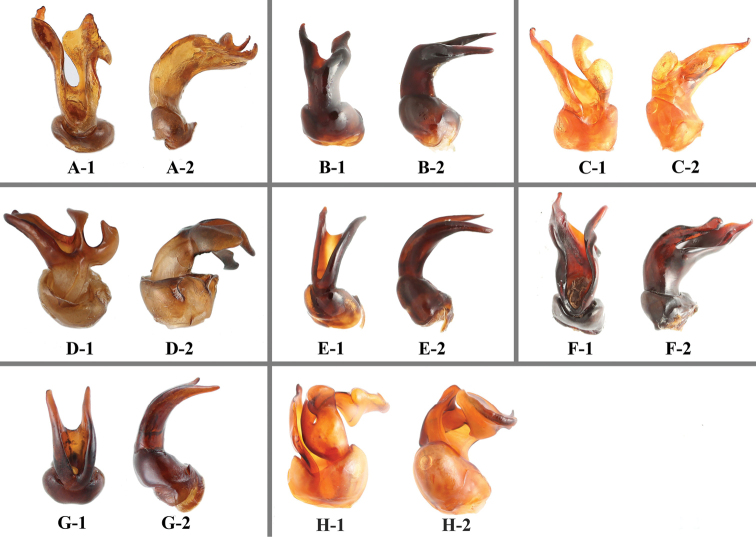
Aedeagus of Sinocymbachus spp AS.
angustefasciatusBS.
bimaculatusCS.
decorusDS.
excisipesES.
humerosusFS.
luteomaculatusGS.
parvimaculatusHS.
quadrimaculatus. 1 ventral view 2 lateral view.